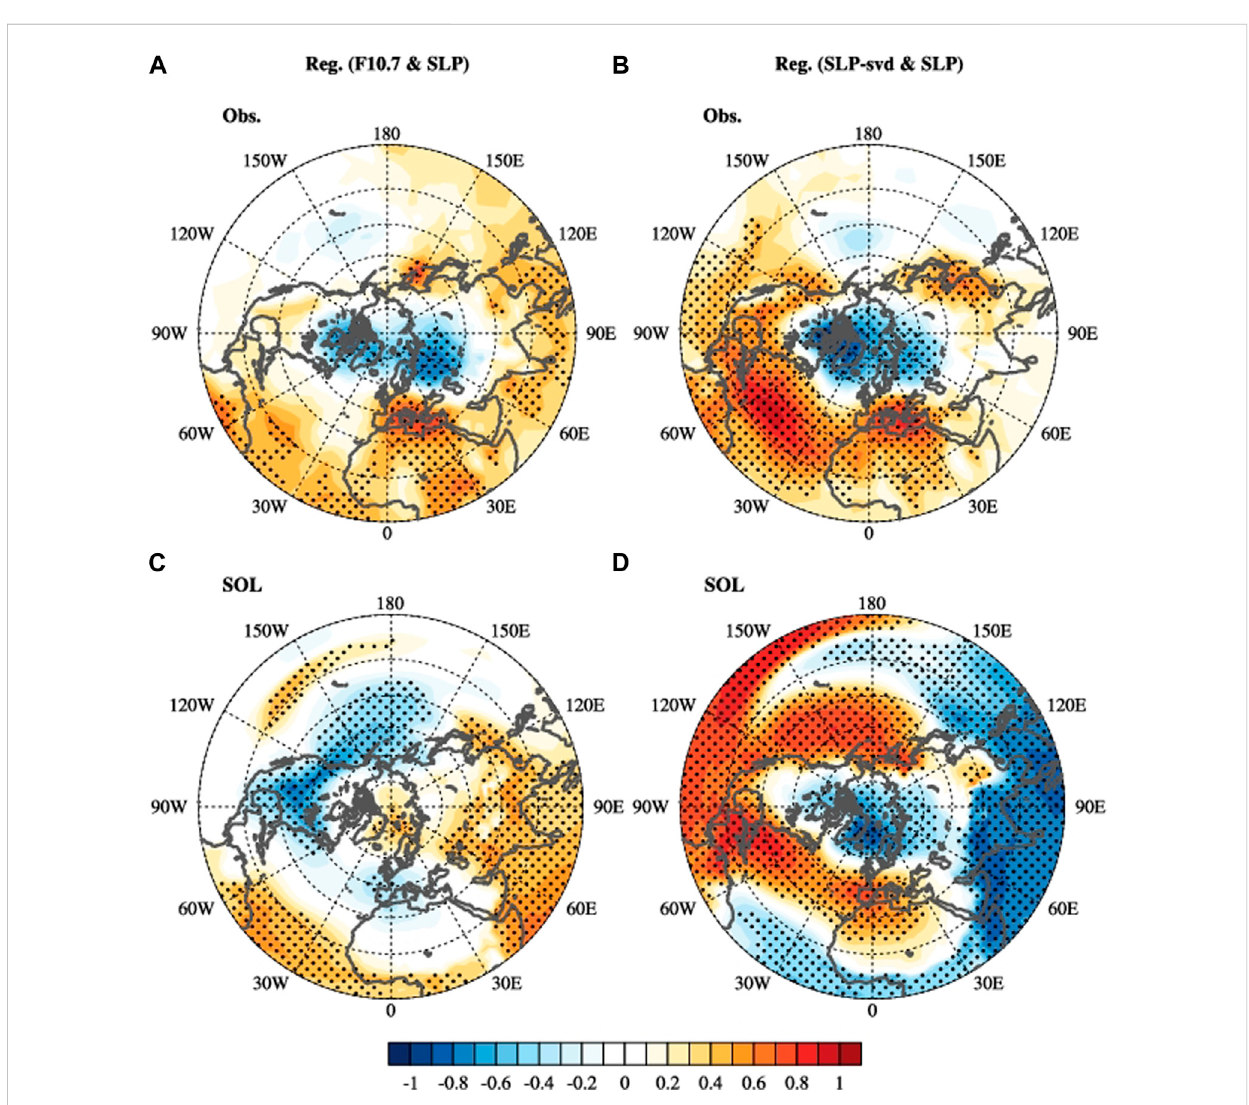
FIGURE 8 (A) RegressionmapoftheDJF-meanF10.7indexontotheobservedDJF-meanSLPanomaliesintheHSsubset. (B) Sameas (A) ,butregressedbythe standardized SLP-svd time series. (C,D) Are the same as the (A,B) , but produced by using the DJF-mean F10.7 index and the simulated DJF-mean SLP anomalies in the SOL experiment. Stippled regions indicate statistical signi fi cance above the 90%